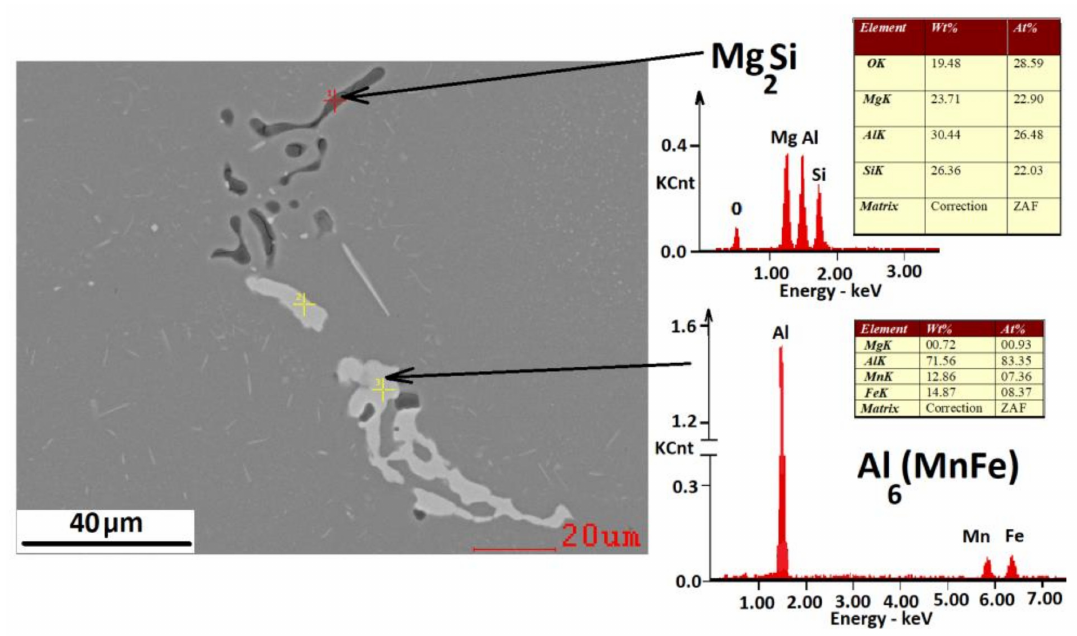
Figure 8. Chemical composition of the large intermetallic particles in 1565